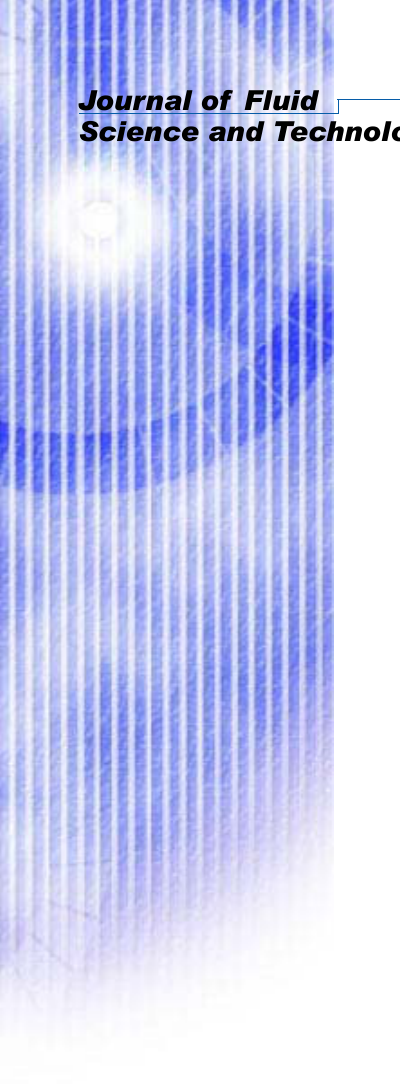
Table 1 General Specifications of the Model